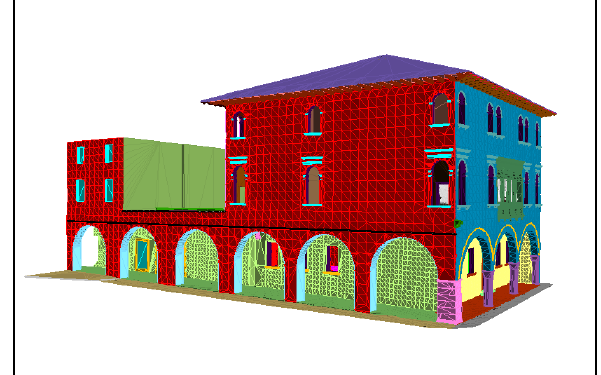
Figure 2. Advanced 3D model obtained by EasyCUBE.